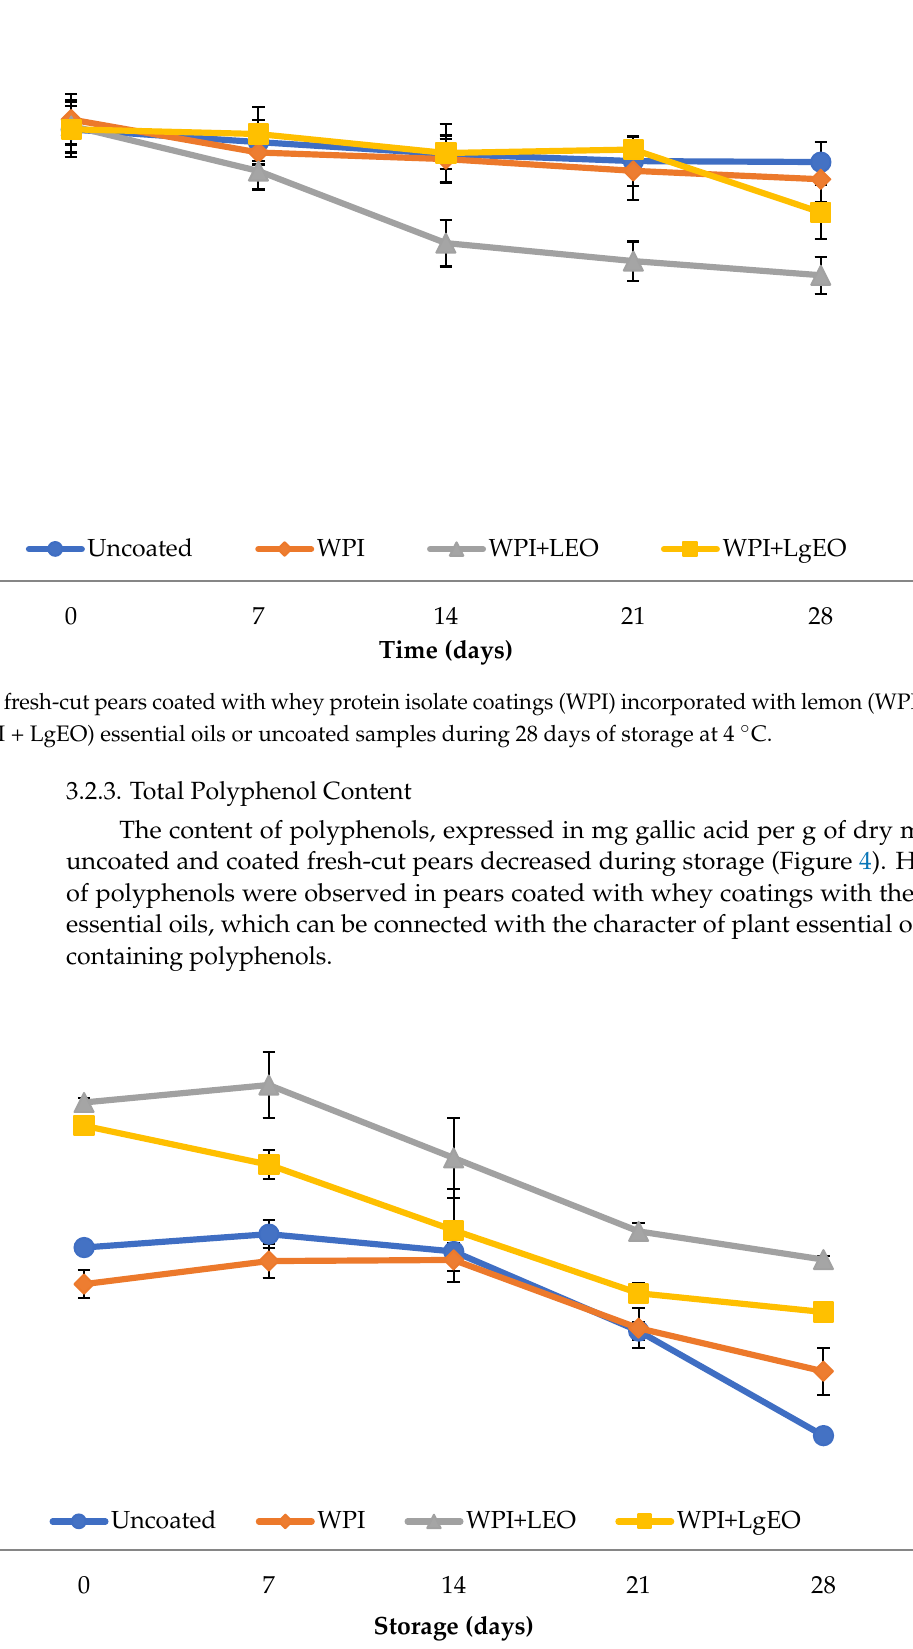
Figure 4. Polyphenols content of fresh-cut pears coated with whey protein isolate coatings (WPI) incorporated with lemon (WPI + LEO) and lemongrass (WPI + LgEO) essential oils or uncoated samples during 28 days of storage at 4 °C.